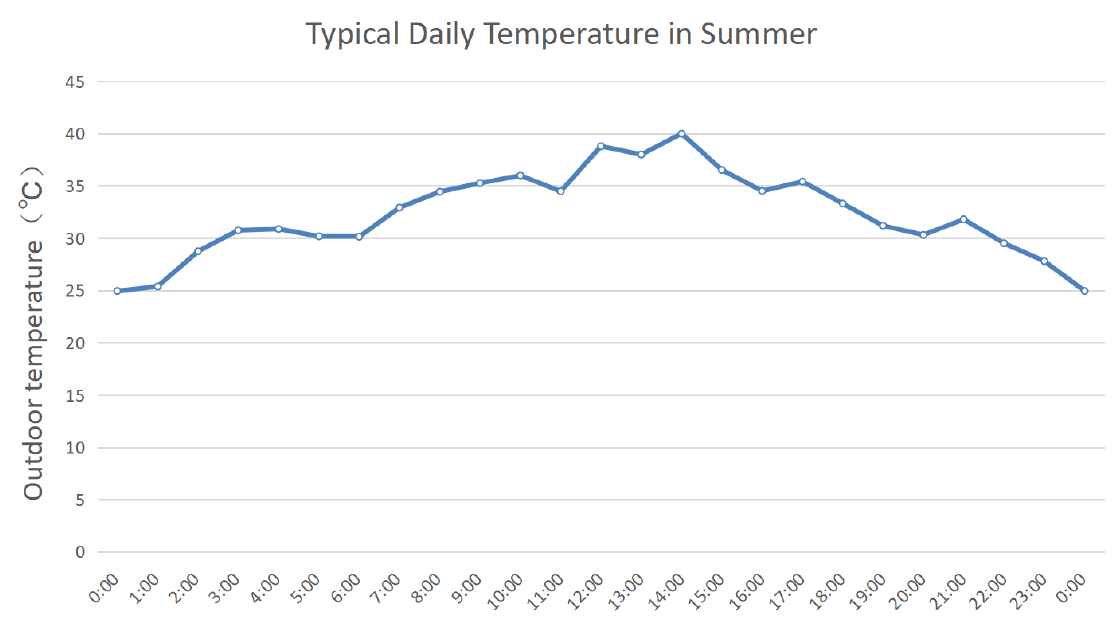
Figure 5. Typical Daily Temperature in Summer.